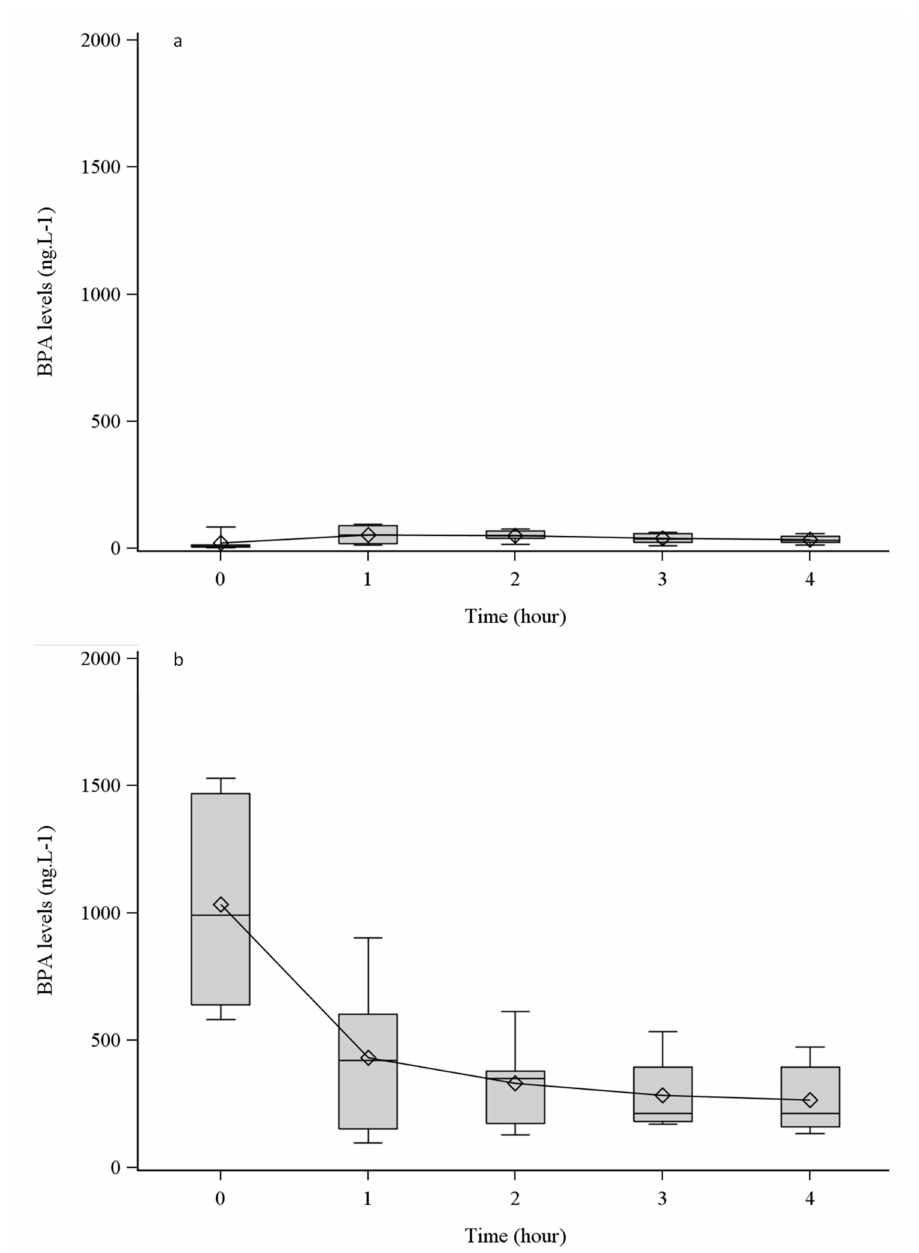
Figure 3. Bisphenol A (BPA) concentrations in ultrapure dialysate ( a ) and in replacement fluid ( b ) versus time profiles. Box plot showing median and interquartile range (IQR, 25th–75th percentile) of BPA ( ♦ : mean